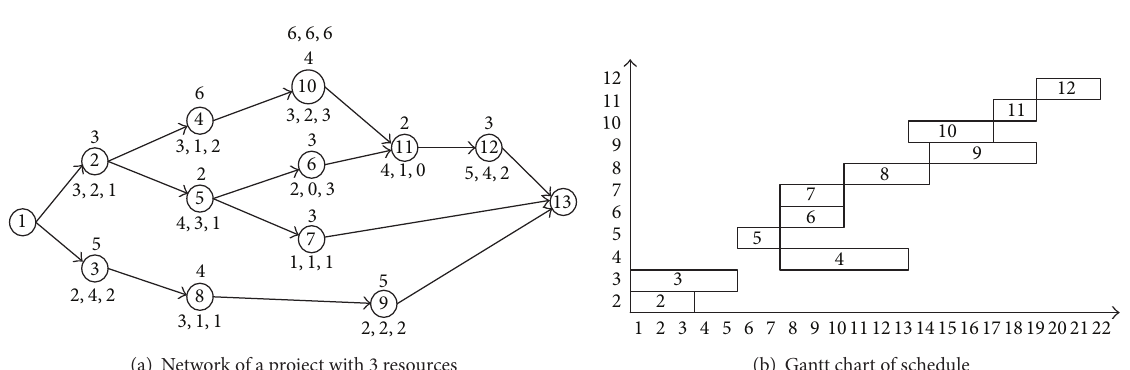
Figure 2: Flowchart of RCPSP PA SFLA.